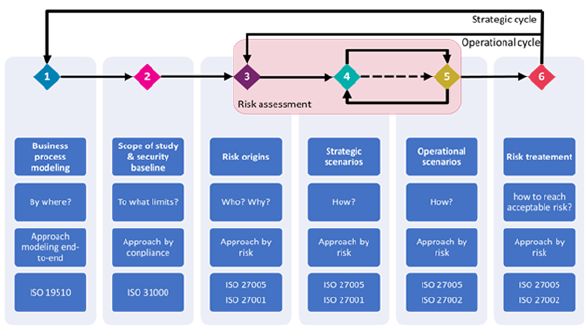
Table 1. Flowchart methodology components